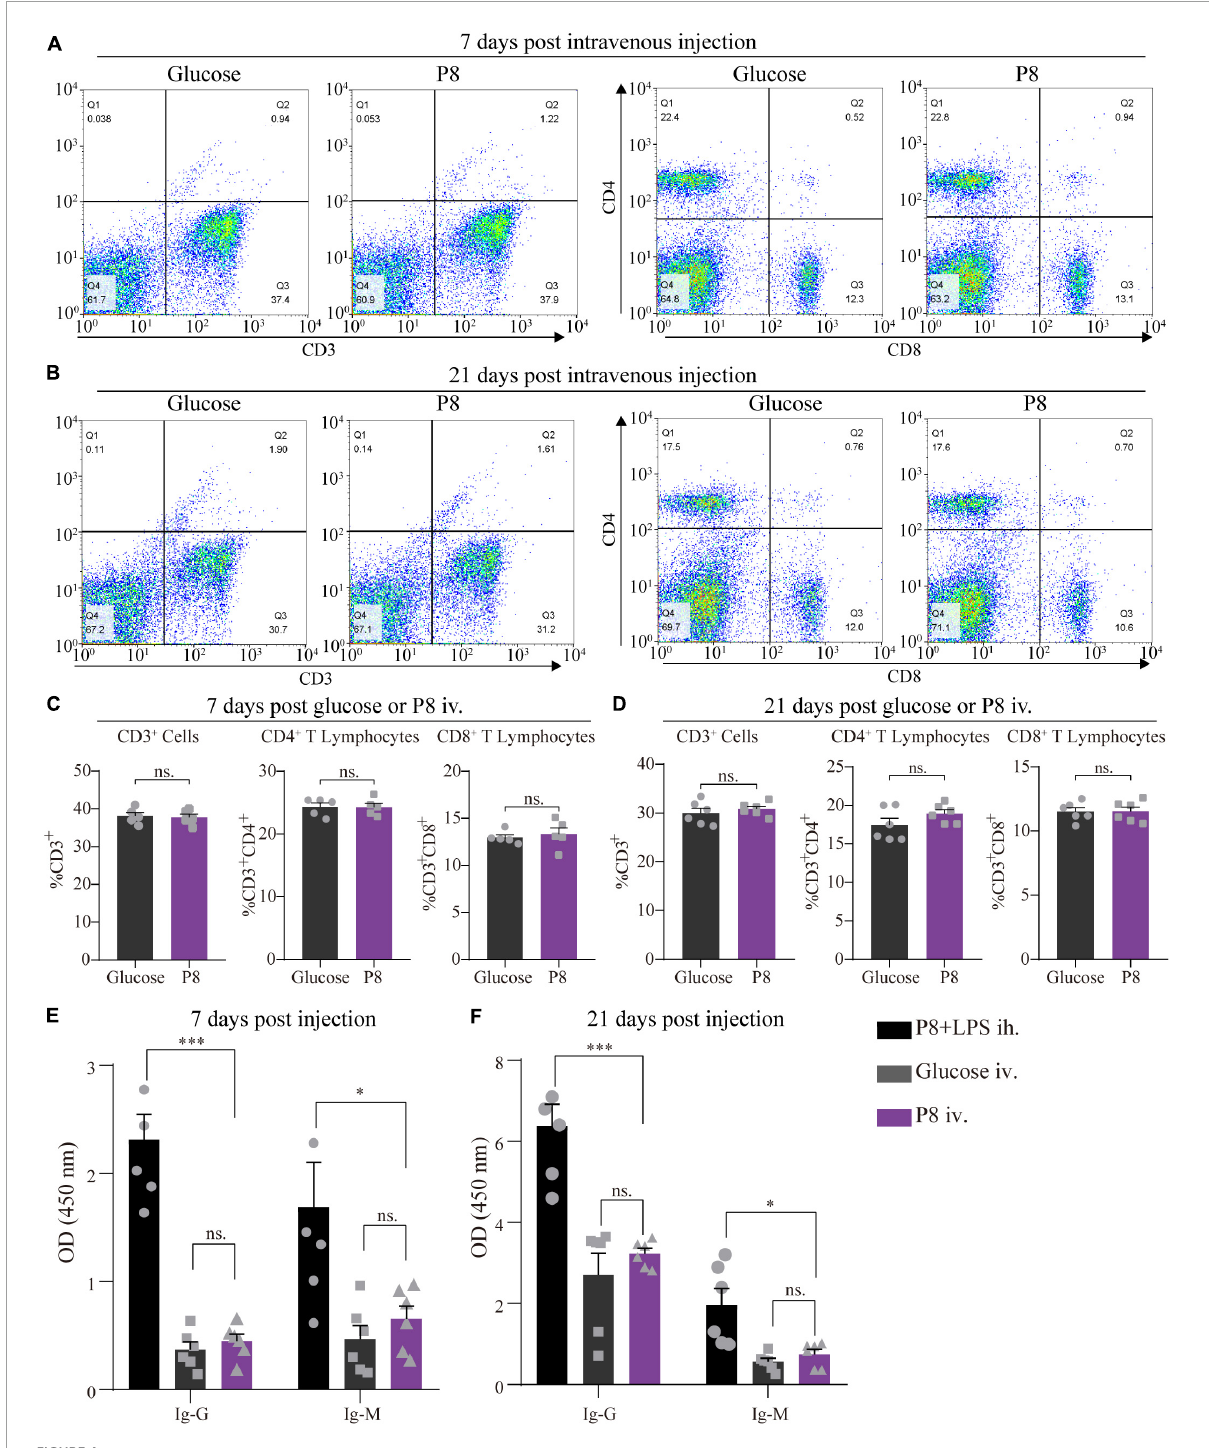
FIGURE4 No significant P8-specific antibody production and CD4 + , CD8 + T lymphocytes response after P8 intravenous injection. (A,B) The percentage of splenic CD4 + and CD8 + T cells were detected by flow cytometry after 7 days injection daily and 21 days intravenous injection of P8 (7 days injection daily following 14 days injection every other day of P8). (C,D) Statistical analysis of Flow cytometry detection. Compared with the control, flow cytometric analysis showed that animals with intravenous injection of P8 for 7 days (C) and 21 days (D) presented no significant change of CD4 + , CD8 + T lymphocytes. n = 6 per group. P8-specific IgG and IgM levels were detected in mouse sera by ELISA after 7-day (E) and 21-day (F) P8 injection. P8 + LPS ih., P8 + 10ng LPS, hypodermic injection (positive control group); Glucose iv, 5% glucose, intravenous injection; P8 iv, P8, intravenous injection. n = 6 per group. * p < 0.05; *** p <